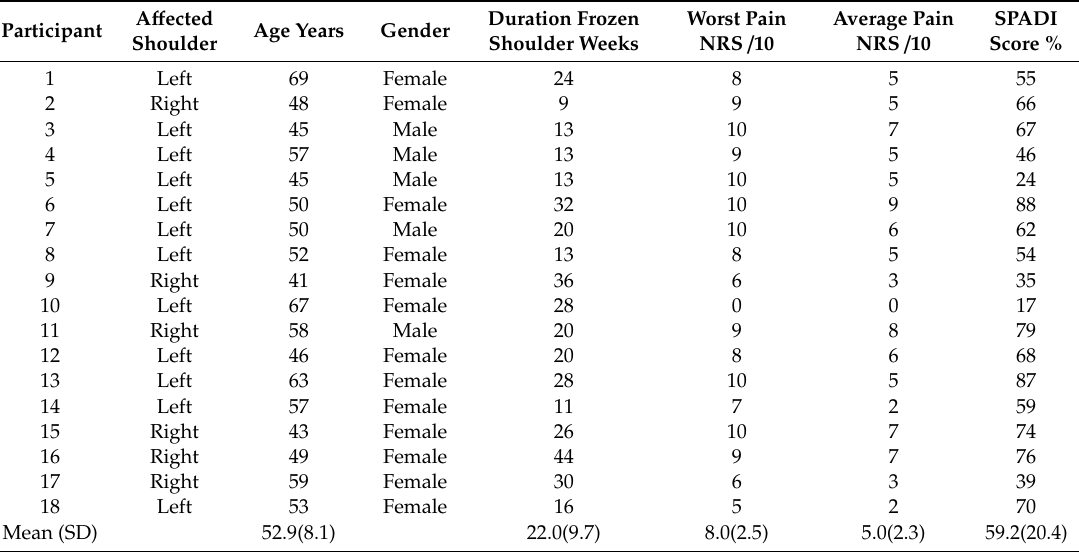
Table 1. Participant demographic